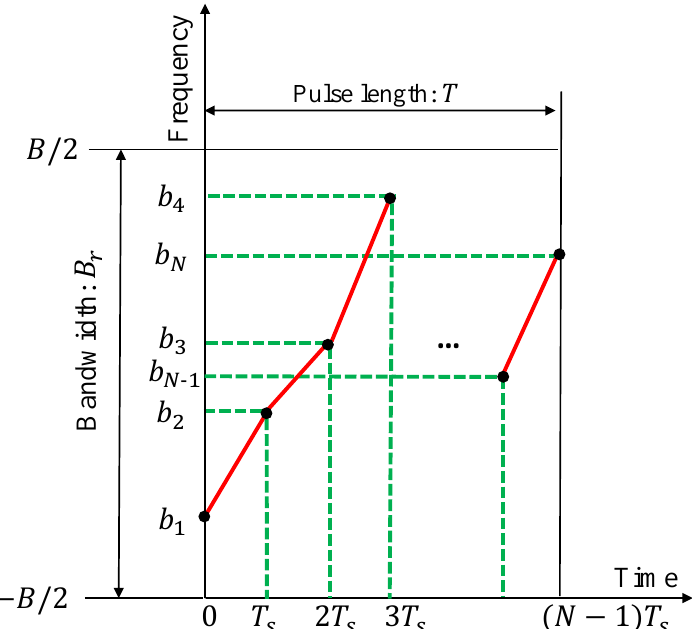
Figure 1. Illustration of the instantaneous frequency